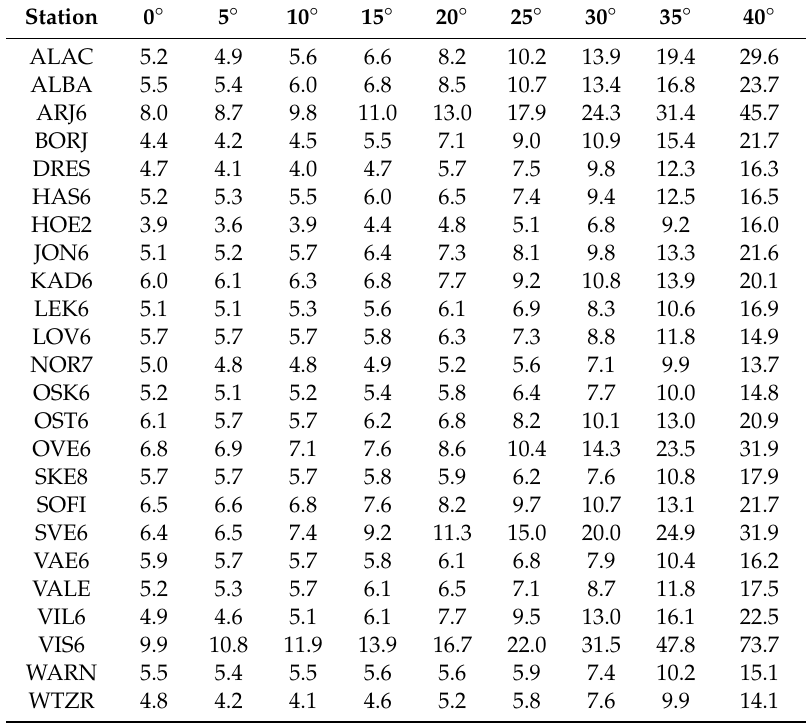
Table A3. Standard deviations of height for solutions based on individual calibrations. Values are in